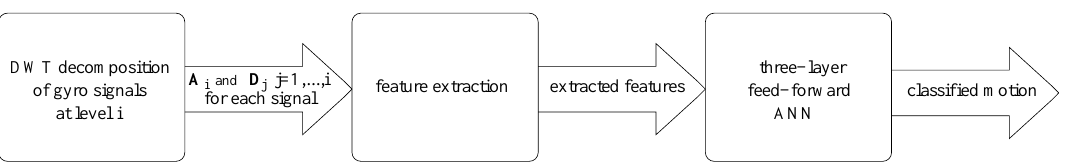
Figure 7. The block diagram of the processing stages using DWT decomposition and